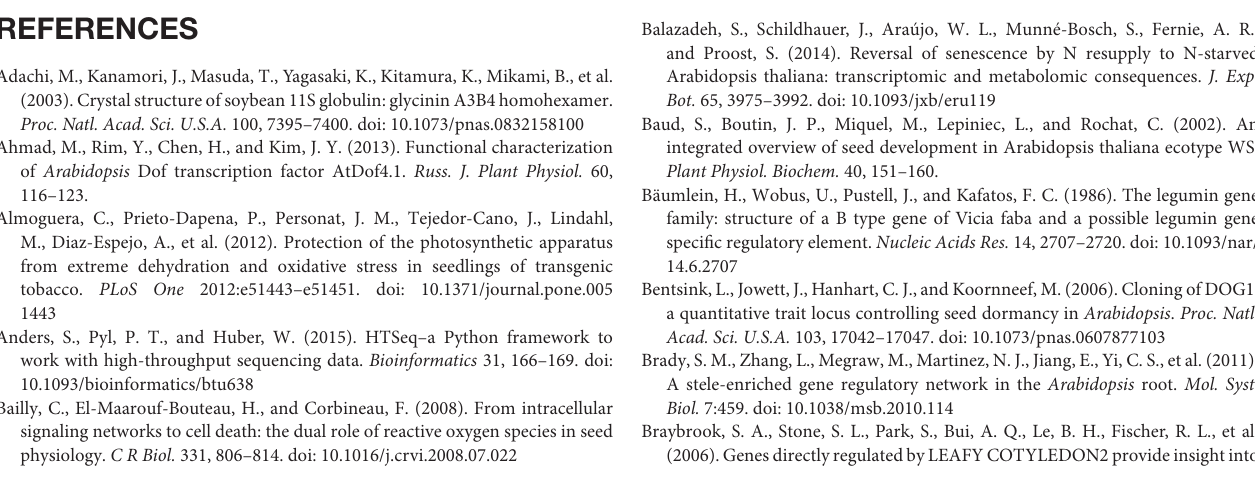
Supplementary Figure 1 | Output image from the eFP (electronic fluorescent pictographic) browser showing the expression pattern of DOF4.1 in the Developmental series generated by Schmid et al. (2005, Map of Arabidopsis Development) and colleagues from Detlef Weigel’s group in Tübingen. Each pictograph is colored according to the level of expression for the gene on of interest (Absolute)